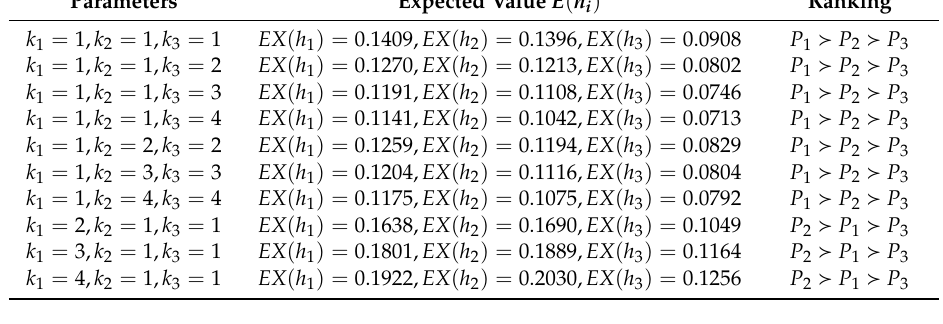
Table 4. Ranking results with different parameter  .